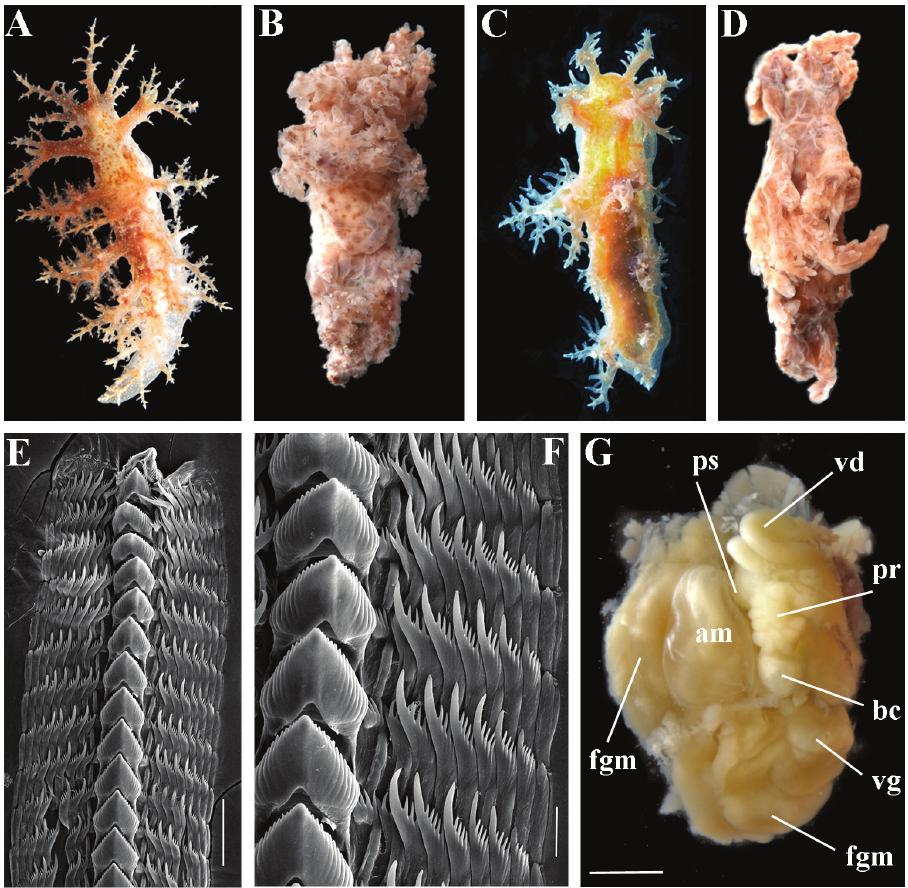
Figure 1. Dendronotus primorjensis , type material from Zoological Museum MSU: A holotype ZMMU Op-419, live, 35 mm in length, dorsal view B fixed holotype ZMMU Op-419 C paratype ZMMU Op- 420, live, 21 mm in length D fixed paratype ZMMU Op-420 E radula of the holotype ZMMU Op-419, posterior part, SEM; F same, details G reproductive system of the holotype ZMMU Op-419. Abbreviations: am ampulla; bc bursa; fgm female gland mass; pr prostate; ps penial sheath; vd vas deferens; vg vagina. Scale bars E = 100 µm F = 30 µm G = 1 mm. Photos and SEM images by T.A. Korshunova and A.V. Martynov (Figures A, E, and F were published as part of the original description by Martynov et al. 2015a). bearing deep furrows. Lateral teeth narrow, with relatively long curved cusp, bearing 3–6 distinct denticles (Fig. 1F). Outermost lateral teeth almost devoid of denticles. Reproductive system triaulic (Fig. 1G), ampulla twice folded. Prostate in holotype rounded, consists of no less than 19 alveolar glands. Distal part of vas deferens rela- tively short, entangled, and expanded to oval penial sheath and relatively long and curved conical penis. Vagina moderate in length. Bursa copulatrix large, rounded, elongated, seminal receptaculum placed distally (nomenclature of the seminal reser- voirs according to Stout et al.